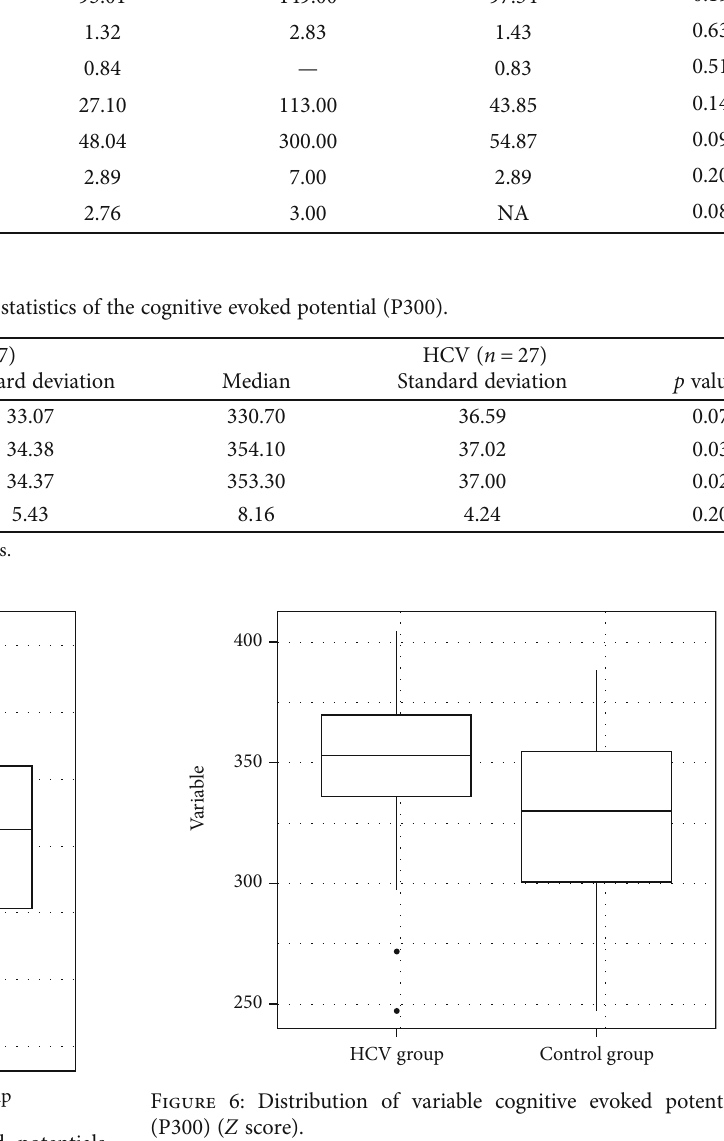
Figure 5: Distribution of variable cognitive evoked potentials (P300) (latency P3b).